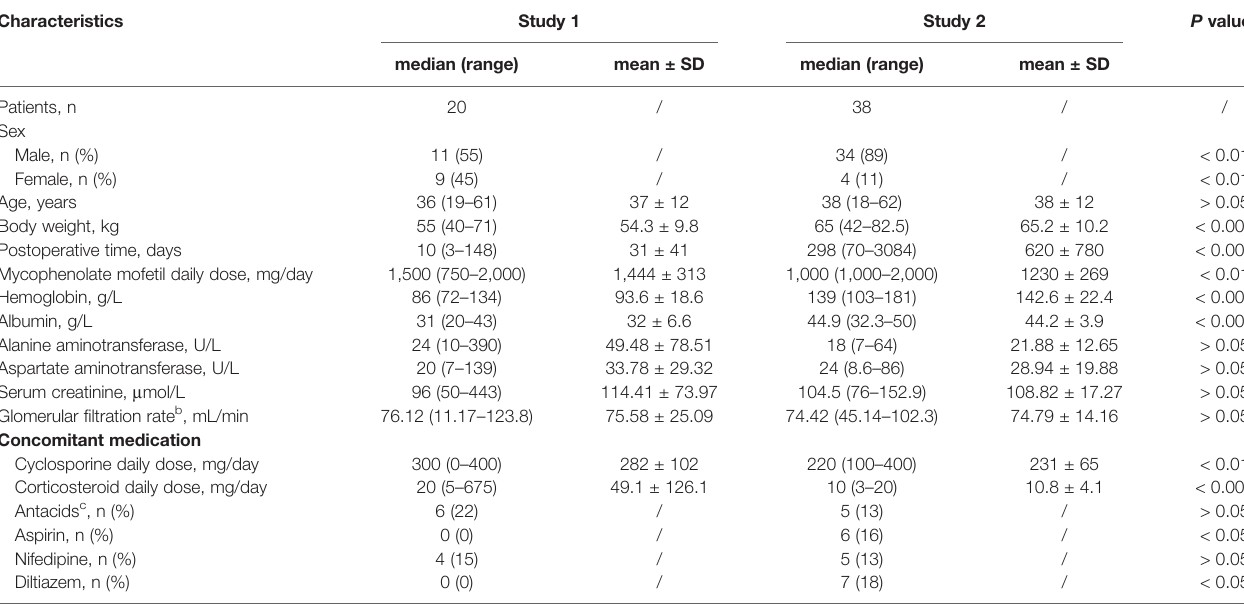
TABLE 1 | Patient characteristics and clinical